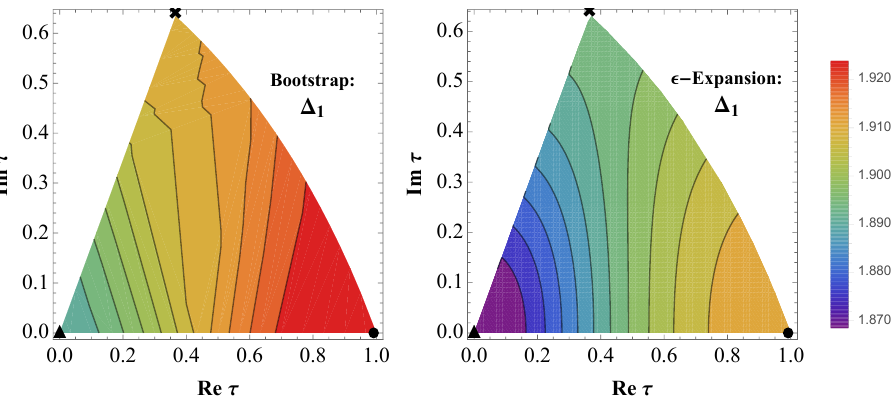
Figure 9 . Left: upper bounds on the singlet scaling dimension (cid:1) 1 for all (cid:28) in the fundamental domain F de(cid:12)ned in (cid:12)gure 1, computed using the G (cid:13)avor symmetry crossing equations with (cid:3) = 19. Right: resummed 3-loop 4 (cid:0) " expansion values for this same quantity. In all plots the cross, circle, and triangle denote the enhanced symmetry points (cid:28) = 1 (cid:6) XYZ models respectively.